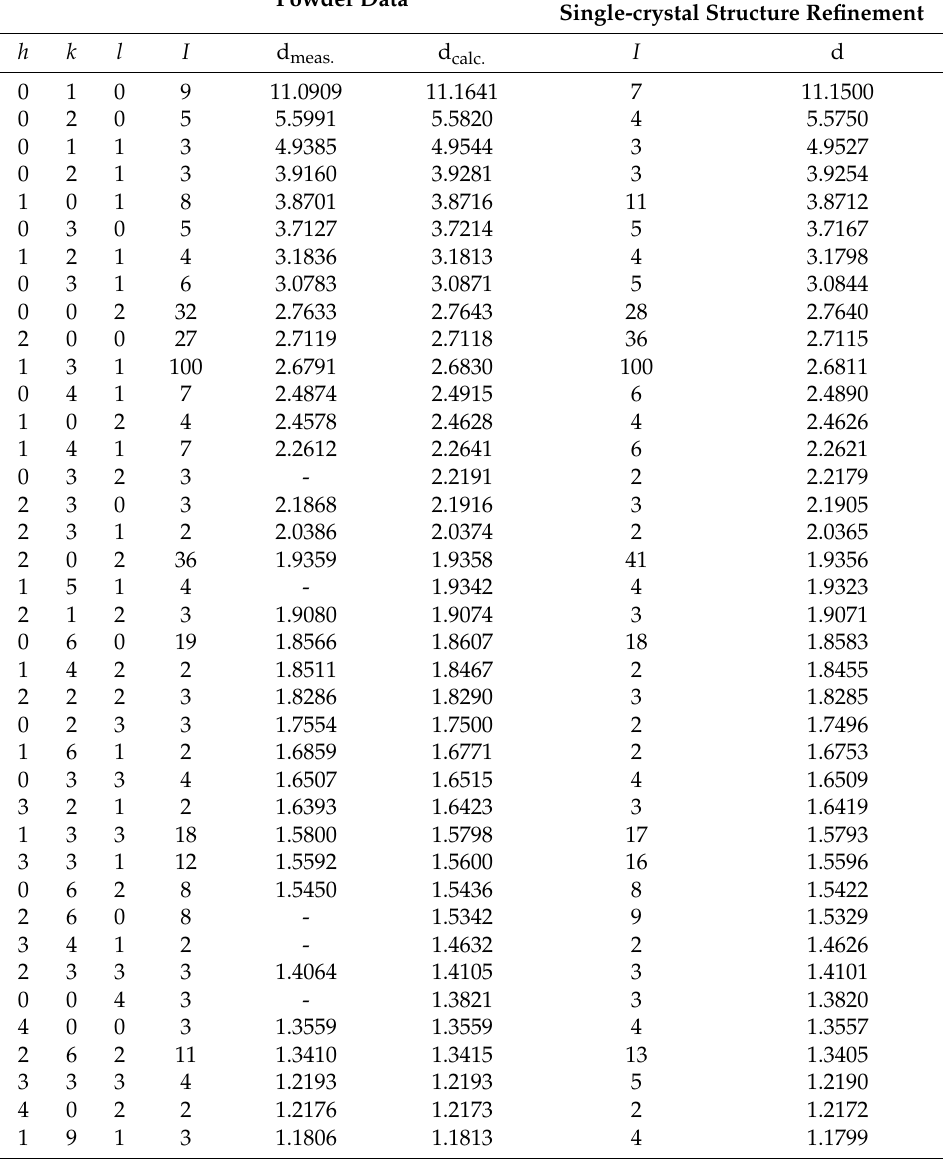
Table 5. Measured and calculated X-ray powder diffraction data (d in Å) for sharyginite. The strongest diffraction lines are given in